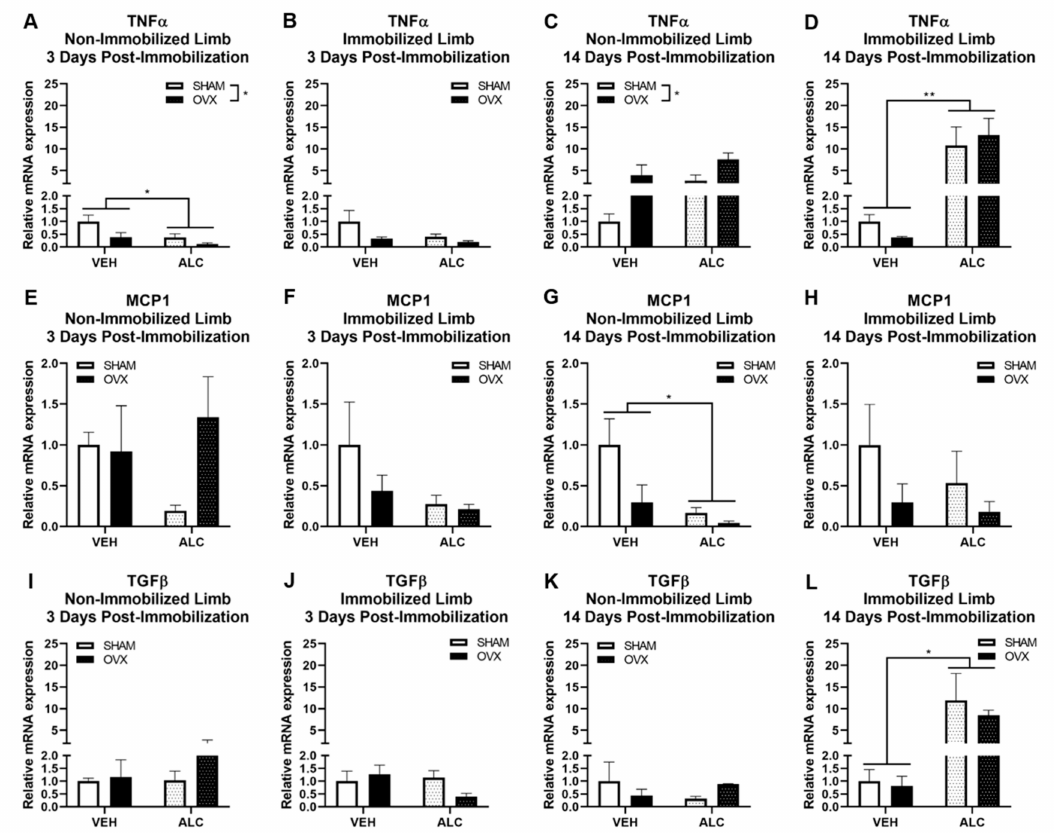
Figure 4. mRNA expression of inflammatory and fibrotic genes in the vastus lateralis muscle: tumor necrosis factor (TNF) α after three days of post-immobilization recovery in the nonimmobilized ( A ) and immobilized ( B ) hind limb; TNF α after 14 days of post-immobilization recovery in the nonimmobilized ( C ) and immobilized ( D ) hind limb; monocyte chemoattractant protein (MCP)1 after three days of post-immobilization recovery in the nonimmobilized ( E ) and immobilized ( F ) hind limb; MCP1 after 14 days of post-immobilization recovery in the nonimmobilized ( G ) and immobilized ( H ) hind limb; transforming growth factor (TGF) β after three days of post-immobilization recovery in the nonimmobilized ( I ) and immobilized ( J ) hind limb; and TGF β after 14 days of post-immobilization recovery in the nonimmobilized ( K ) and immobilized ( L ) hind limb with or without alcohol (ALC) and ovariectomy (OVX). Data analyzed by two-way ANOVA (alcohol × ovariectomy), * p < 0.05, ** p < 0.01, Mean ±